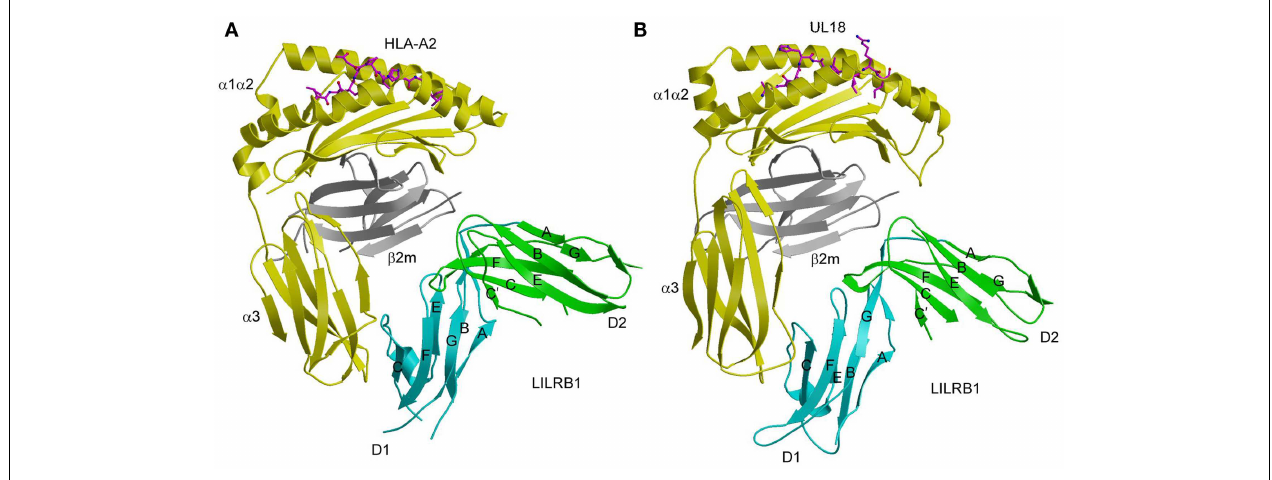
The D1 and D2 domains of LILRB1 are colored in cyan and green, respectively.The secondary structural elements of LILRB1 are labeled. (B) Structure of LILRB1 bound to the HCMV MHC-I mimic UL18